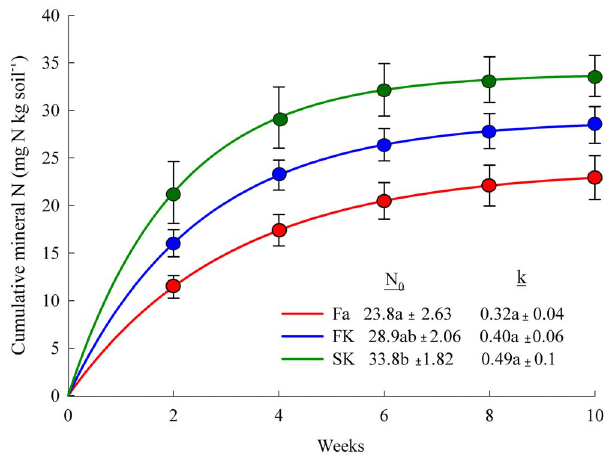
Figure 6. Cumulative N mineralization in soils from the fallow (Fa), first kill (FK) and second kill (SK) treatments during a 10- week aerobic incubation. Soil N mineralization potential (N 0 ) and N mineralization rate (k) were calculated by fitting a non-linear regression model (Nt=N 0 exp (-k t)). Values followed by different letters are significantly different between treatments at # 0.05 by Tukey’s test. Bars represent the standard error.